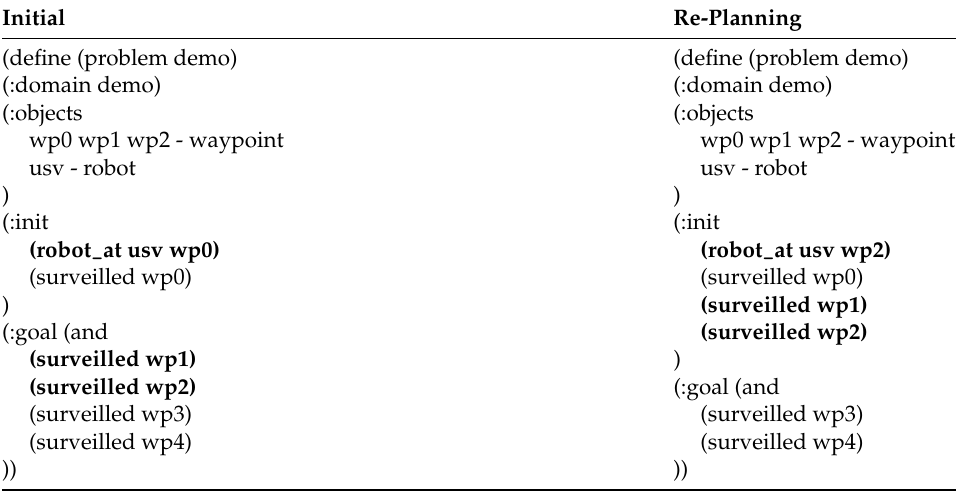
Table 1. Automatically generated PDDL problem for initial and re-planning